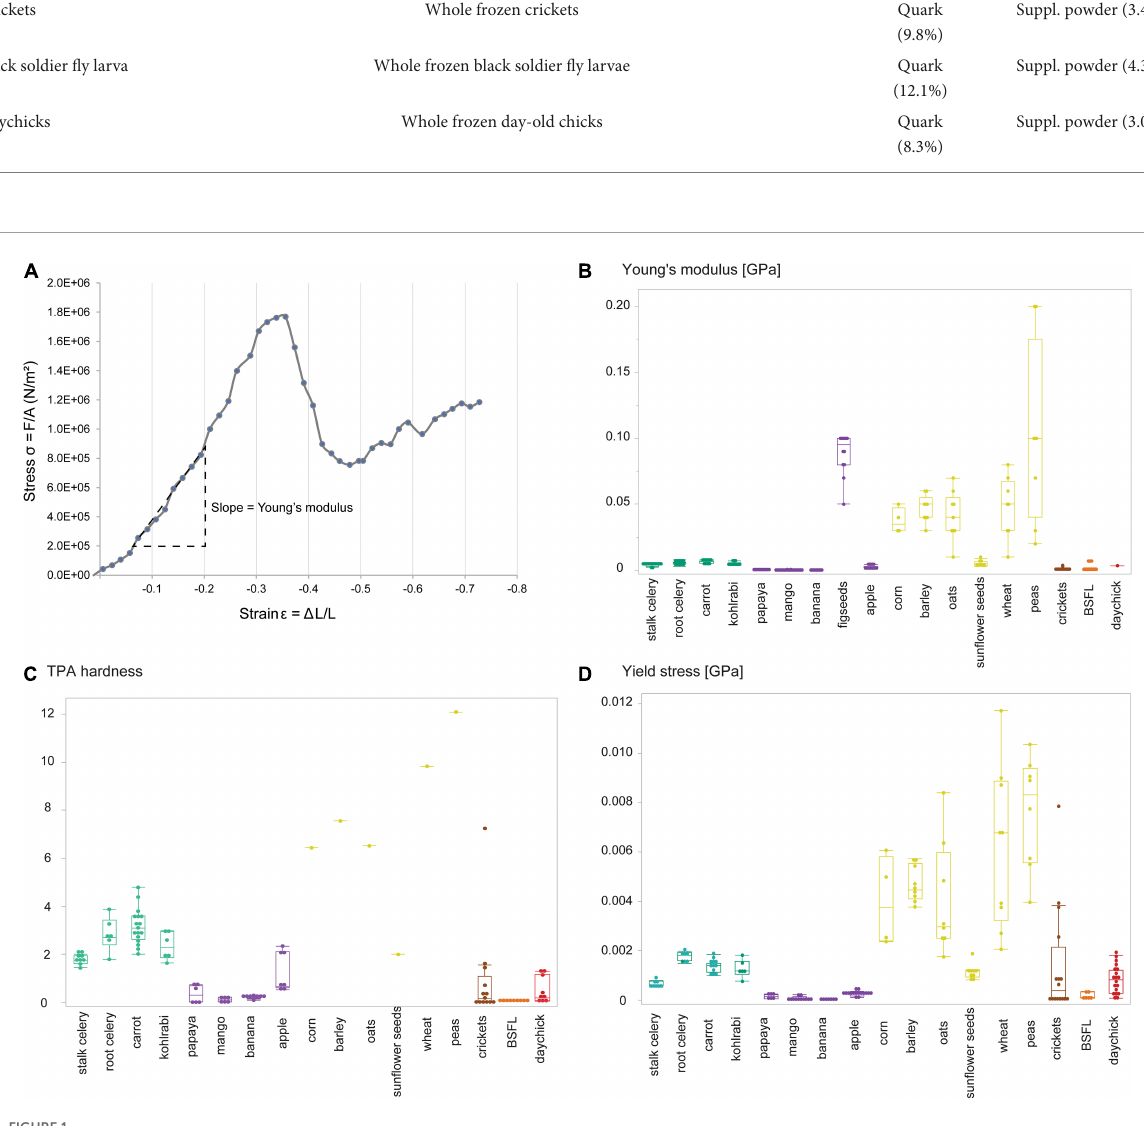
FIGURE1 Mechanical properties of components of near natural diets. (A) Exemplary stress-strain curve obtained for a carrot cube. (B) Young’s modulus, (C) TPA hardness, and (D) Yield stress obtained for the different diet components. TPA hardness is commonly reported unitless but would have the unit N/mm 2 . Colors highlight the different experimental diets to which the individual items belong to. Green = vegetable mix, purple = fruit mix, yellow = seed mix, brown = crickets (including whole crickets, isolated head capsules, and gizzards), orange = black soldier fly larvae (BSFL), red =